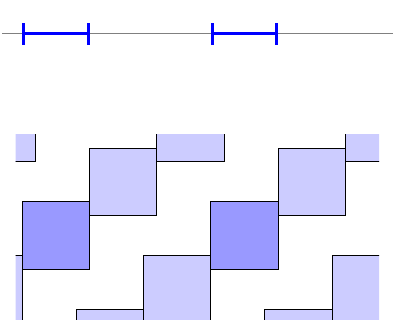
Figure 3: In the case where the rate is bigger than 1 / 2, some intersections of cubes appear automati- cally between times k and k + 1.